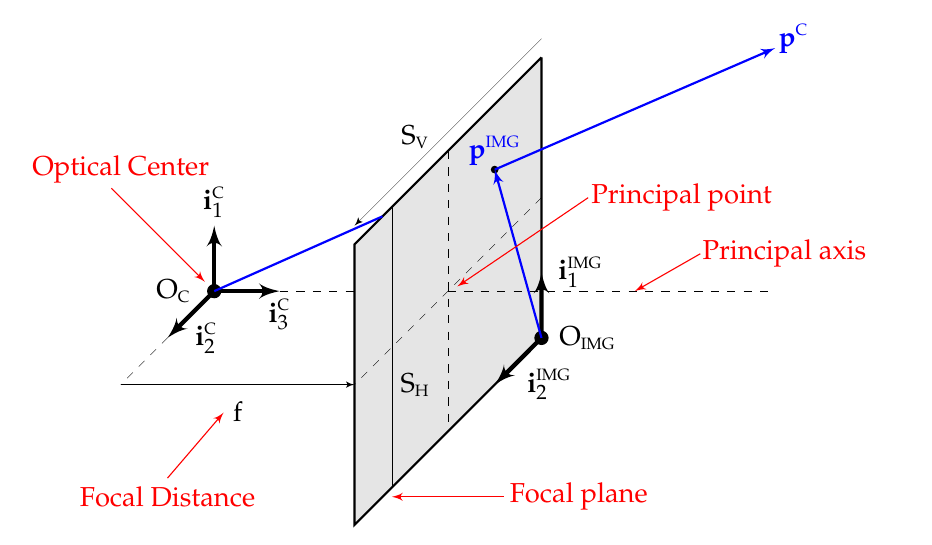
Figure A1. Frontal pinhole camera model.